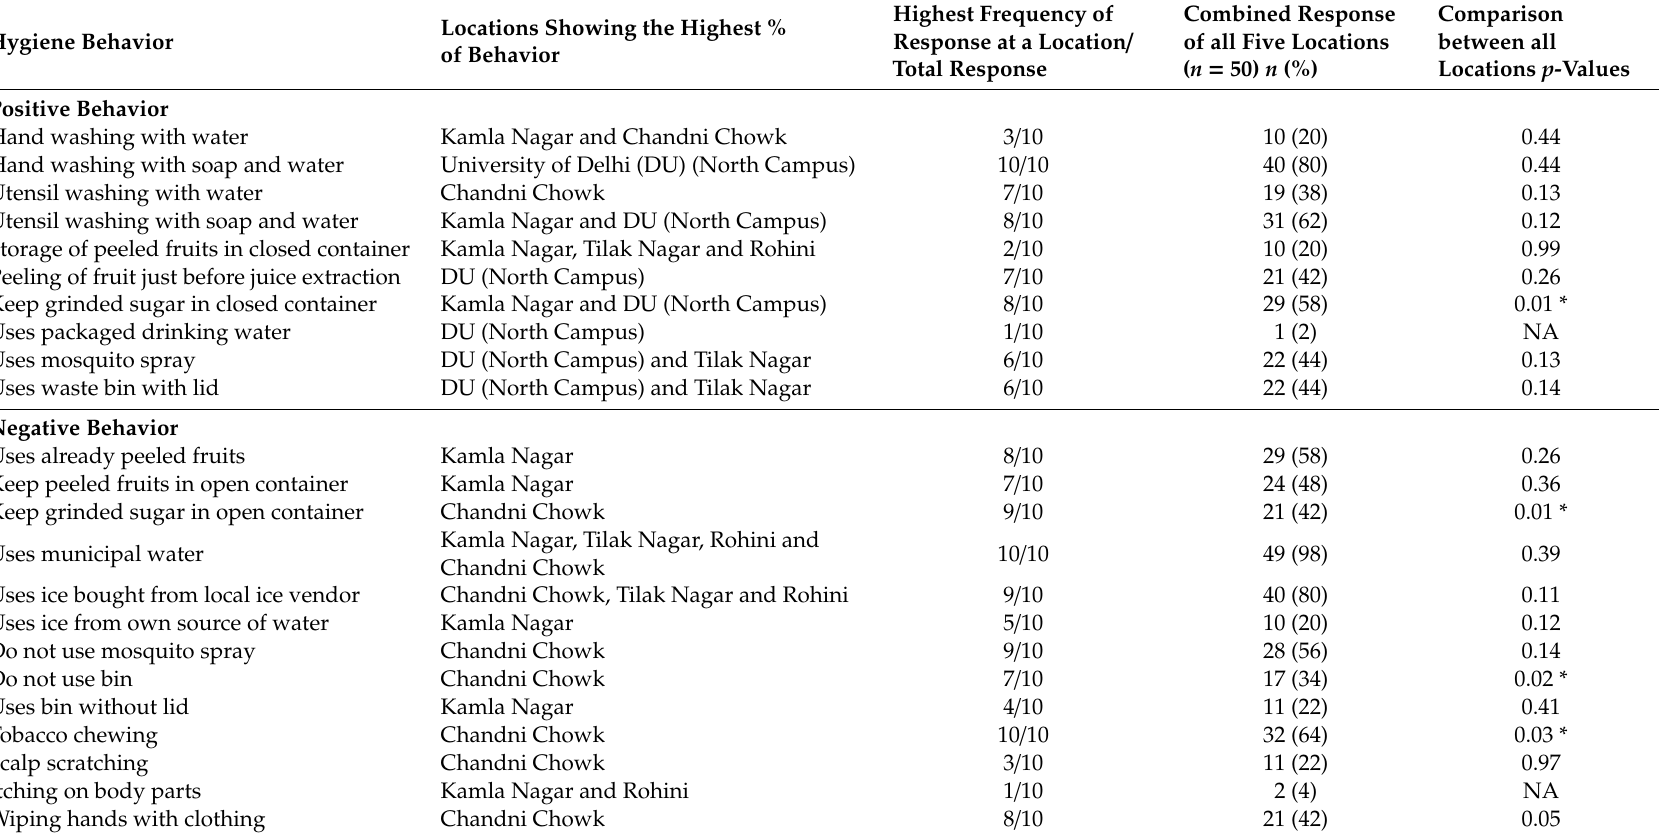
Table 1. Hygiene behavior among the fruit juice vendors from five study areas in urban